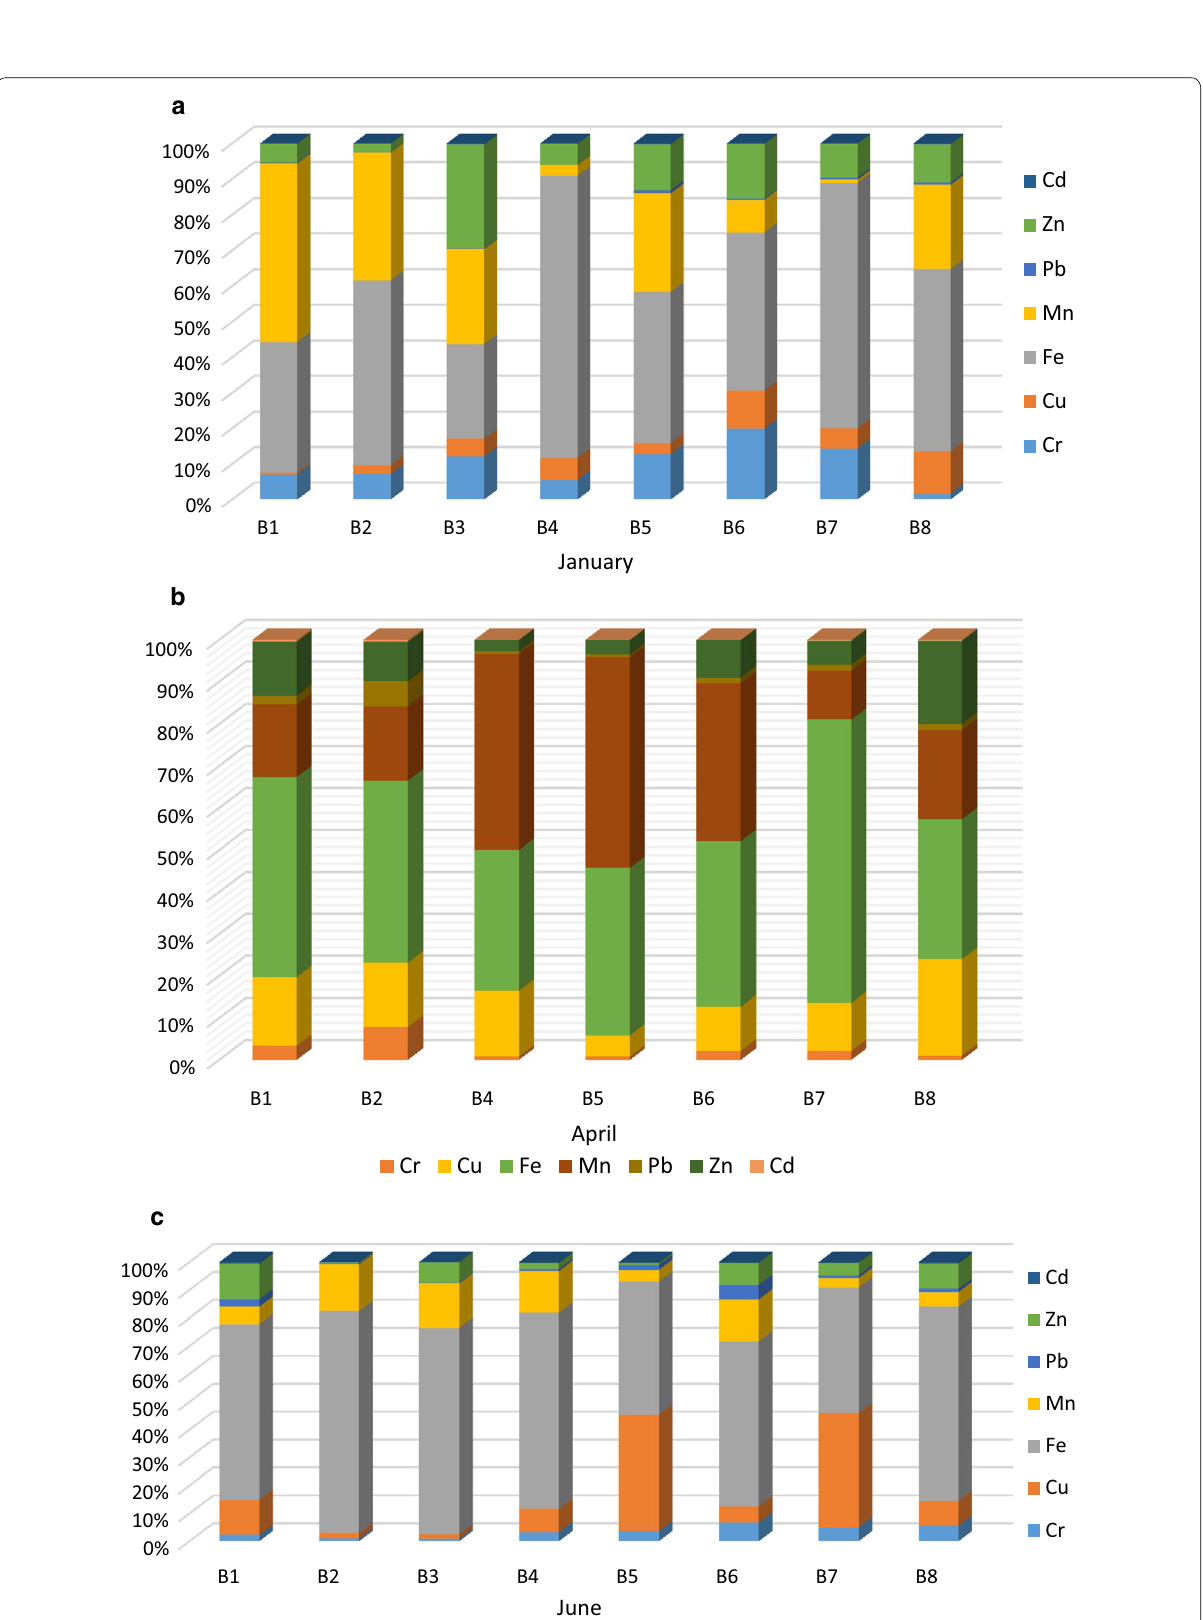
Fig. 1 Mean value of physico-chemical parameters in groundwater samples collected from eight boreholes in Muledane